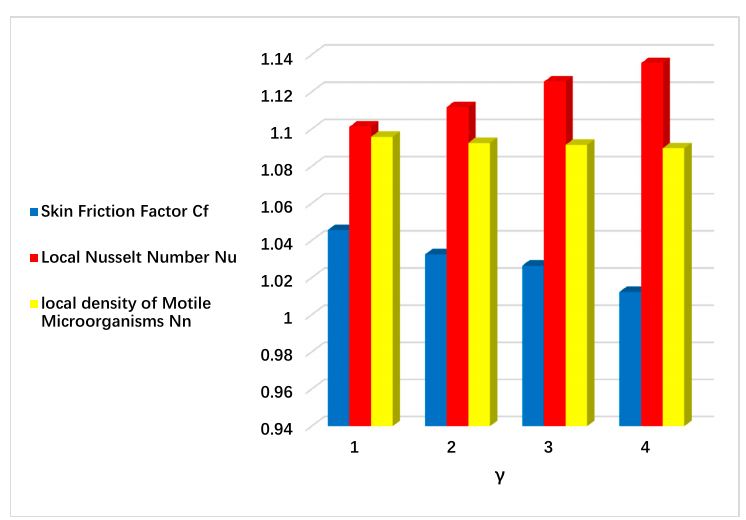
Figure 21. Effect of γ on C f , Nu, and Nn .